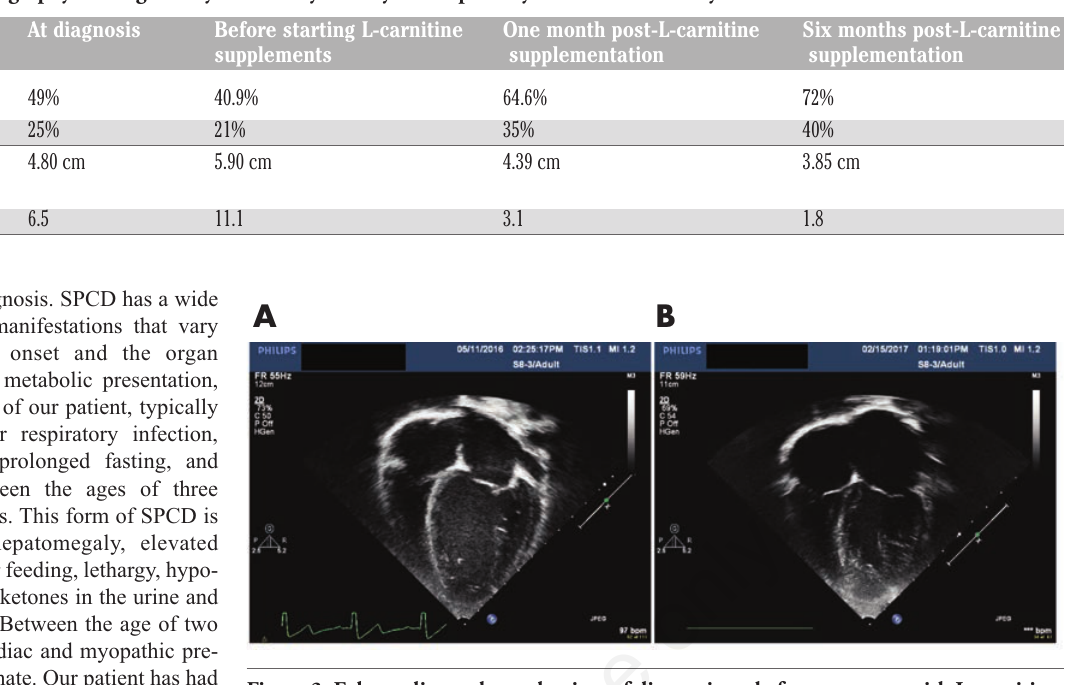
Figure 3. Echocardiography at the time of diagnosis and after treatment with L-carnitine. (A) Transthoracic echocardiography section showing dilated left ventricle at the time of diagnosis; (B) Transthoracic echocardiography section showing normal left ventricular dimensions 6 months following L-carnitine supplementation.